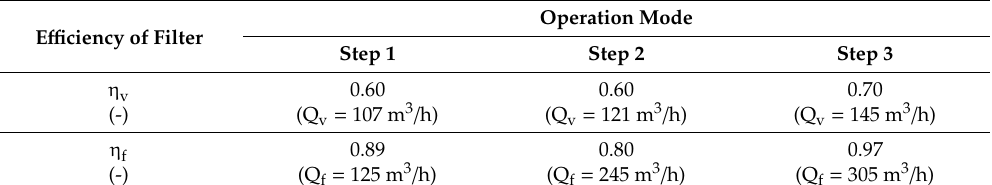
Table 2. Results of parameters η (cid:2932) and η (cid:2916) according to flow rate.